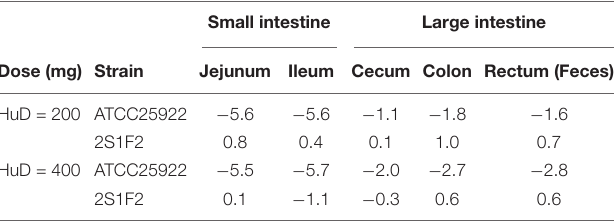
TABLE 5 | Predicted activity ( (cid:49) Log10 CFU/mL) against ATCC25922 and 2S1F2 Escherichia coli strains of the mean minocycline concentrations in pig gut segments corresponding to HuDs of 200 and 400